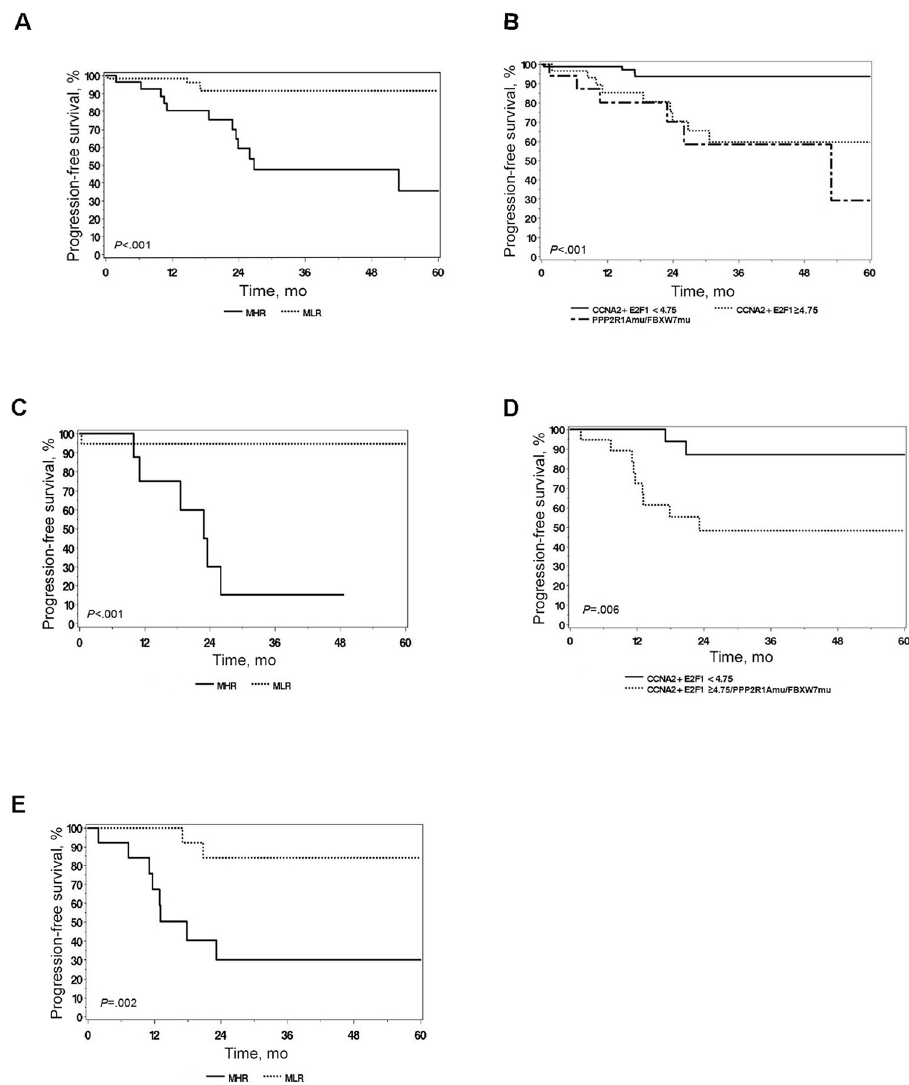
Fig 3. ECPPF stratification of outcomes in endometrioid endometrial cancer. A, Progression-free survival for 85 patients with stage I, grade (G) 1 or G2, � 50% myometrial invasion (MI) disease, stratified by ECPPF as having molecular low risk (MLR; defined as CCNA2 and E2F1 [ CA2 + E2F ] log 2 expression < 4.75, PPP2R1A wild type [-wt], and FBXW7 wt [n = 56]) or molecular high risk (MHR; defined as CA2 + E2F log 2 expression � 4.75, PPP2R1A mutation [-mu], or FBXW7 mu [n = 29]). B, Progression-free survival for 122 patients with stage I-II, G1-G2, < 75% MI disease and patients with G3, < 50% MI disease, stratified according to ECPPF risk cohorts CA2 + E2F < 4.75 (n = 75), CA2 + E2F � 4.75 (n = 29), and PPP2R1A mu/ FBXW7 mu (n = 18). C, Progression-free survival for 28 patients with stage I, G1-G2, � 50% MI disease and CTNNB1 mu, stratified according to MLR (n = 19) and MHR (n = 9) ECPPF . D, Progression-free survival for 42 patients with stage III-IV disease, stage I-II, G2, > 75% MI disease, and G3, > 50% MI disease, stratified according to MLR (n = 22) and MHR (n = 14). E, Progression-free survival for 30 patients with stage III-IV, stratified according to MLR (n = 16) and MHR (n = 14) ECPPF . The CTNNB1 mu cohort was expanded to include all stage I and II, G1 and G2 cases. Among these 39 cases, 95% of missense mutations were in exons 4 and 5 of the CTNNB1 gene. ECPPF efficiently stratified outcomes ( P < .001); the hazard ratio (95% CI) for MHR vs MLR was 19.58 (2.38–161.04; P = .006). These results further underscore the ability of ECPPF to distin- guish high-risk patients traditionally thought to have low-risk EEC.